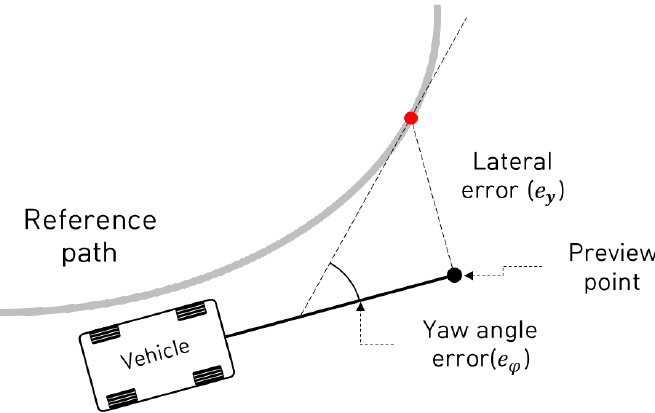
Figure 1. Defined control errors for path tracking.